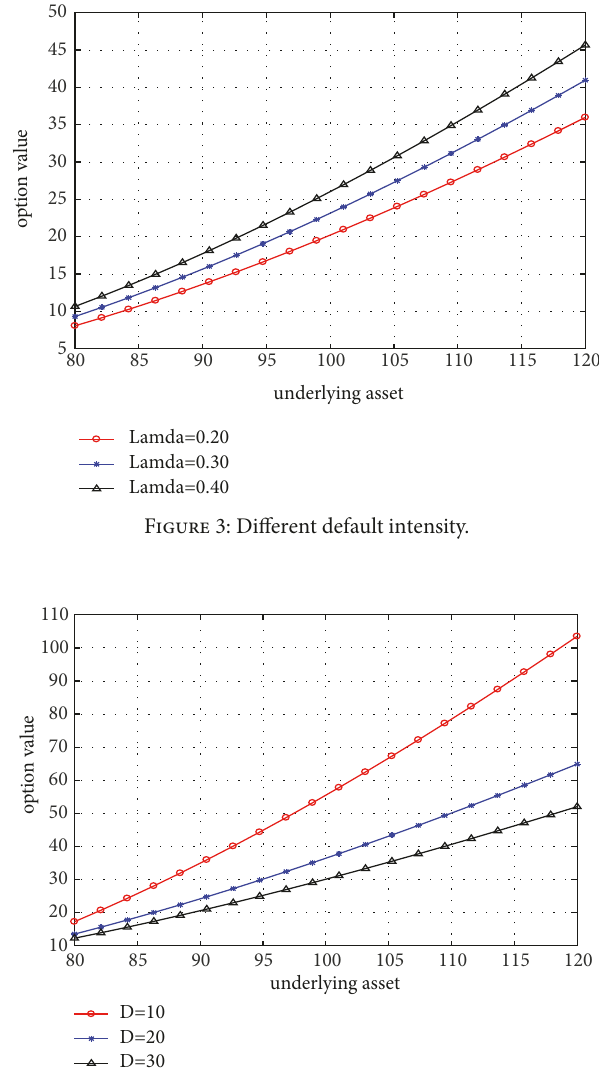
Figure 4: Different